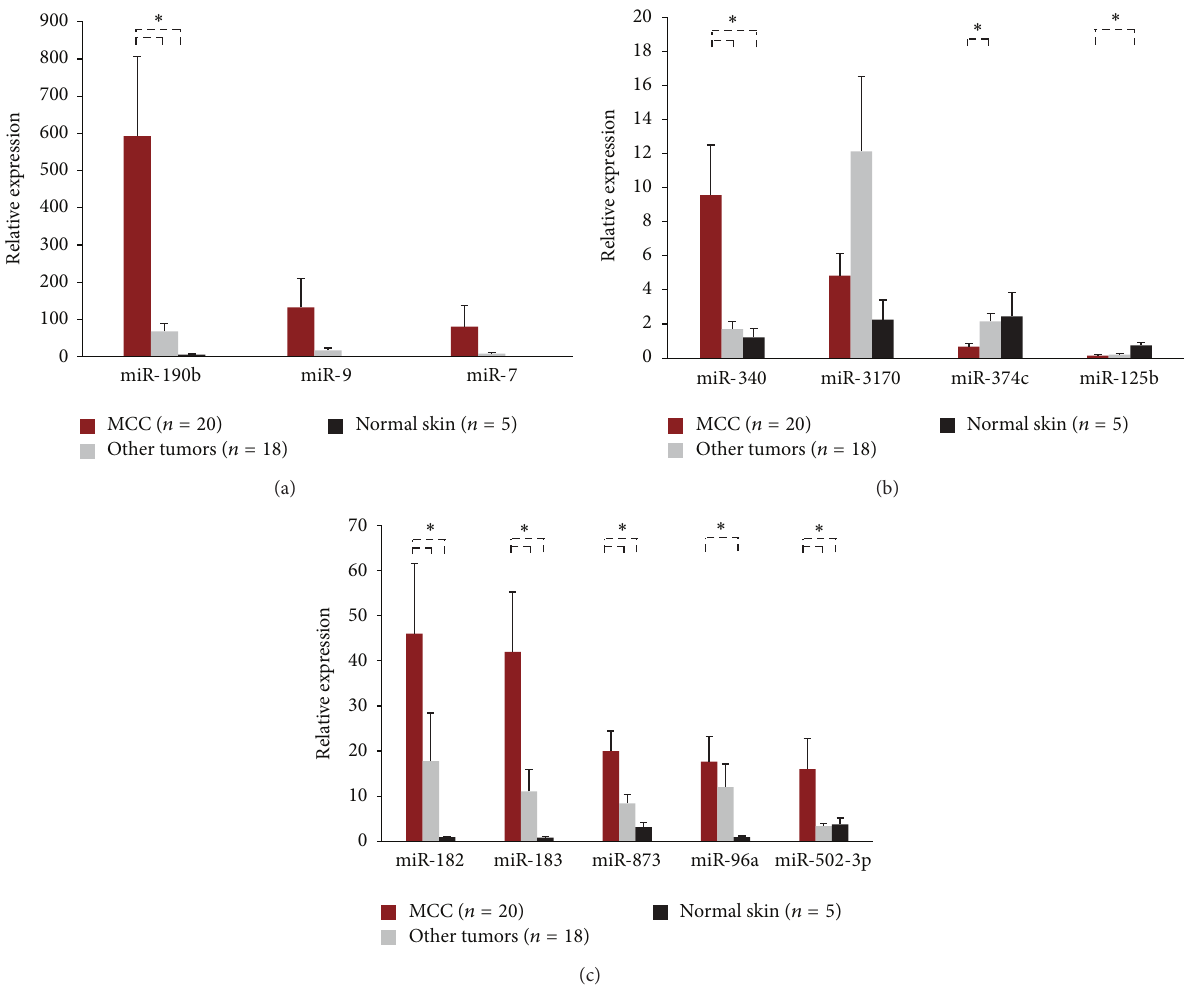
Figure 1: Validation of MCC-miRs via qRT-PCR. Eight microRNAs were confirmed to be upregulated in MCC versus other tumors and normal skin: miR-190b, miR-9, miR-7, miR-182, miR-183, miR-873, miR-502-3p, and miR-340. The tumor group consists of melanoma ( 𝑛 = 5 ), SCC ( 𝑛 = 6 ), and BCC ( 𝑛 = 7 ). Error bars refer to SEM. ∗ Welch’s 𝑡 -test: 𝑃 < 0.05